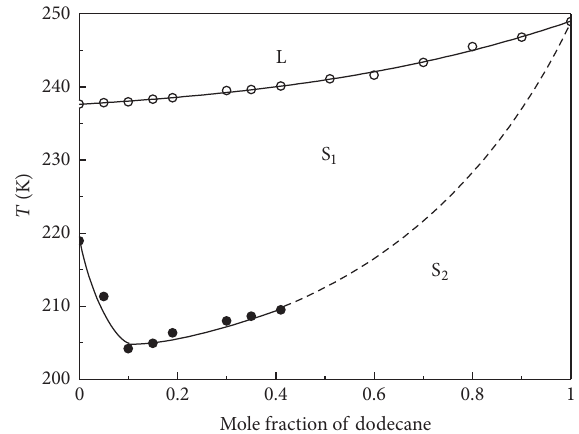
F 9: Experimental phase diagram of C in SBA-15 (17.2nm). tions solid-solid transition temperatures.